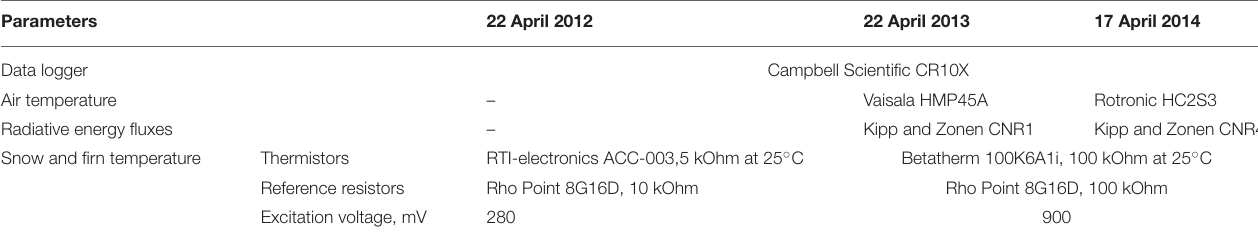
TABLE 1 | Instruments used for measurements of the air temperature, radiative energy fluxes, and subsurface temperature.